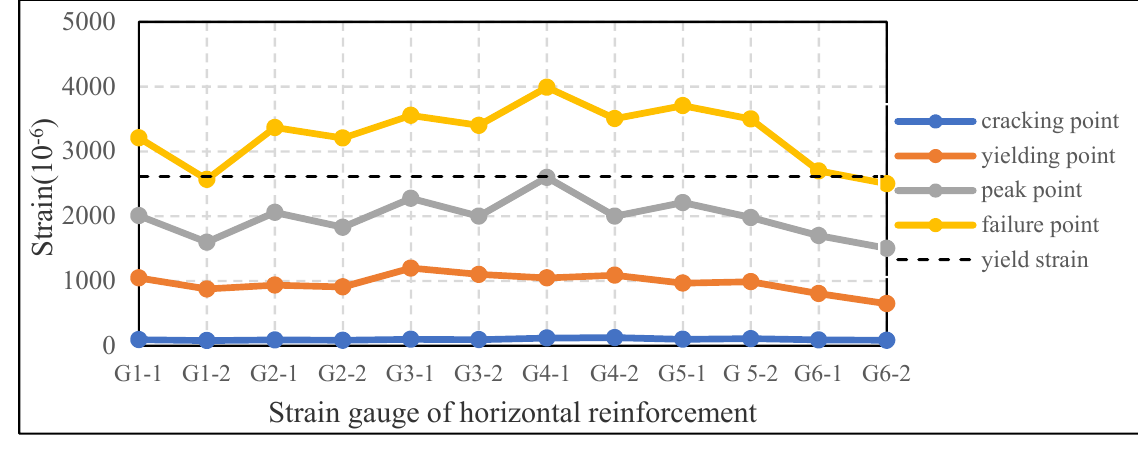
Figure 14. Vertical reinforcement strain distributions along the wall length.